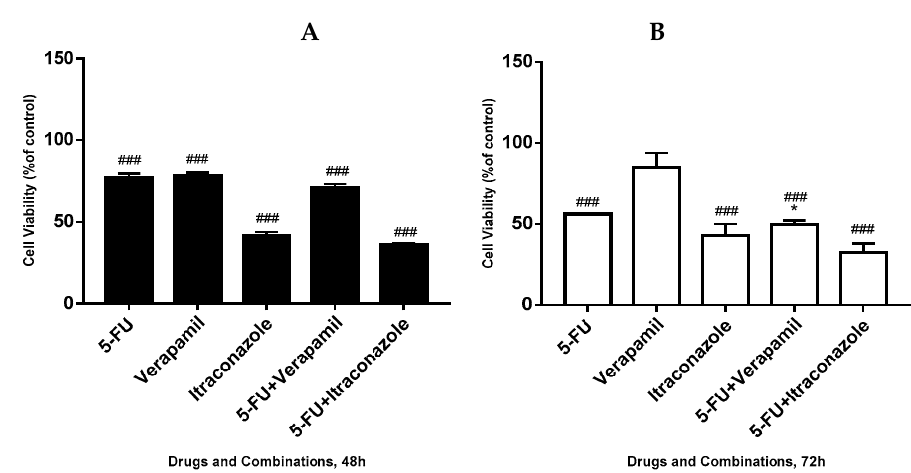
Figure 7. Effect of 5-FU, verapamil, itraconazole, and respective combinations of the last two drugs with 5-FU on the viability of MCF-7 cells, for 48 h ( A ), 72 h ( B ). Each drug and drug combination were added in fresh medium, in sextaplicates. Results are presented as mean ± SEM, and represent the viability of cells (% of control) of four independent experiments. ### p < 0.001 vs. control; * p < 0.05 vs. single drug of the combination with more effect on cell viability reduction.